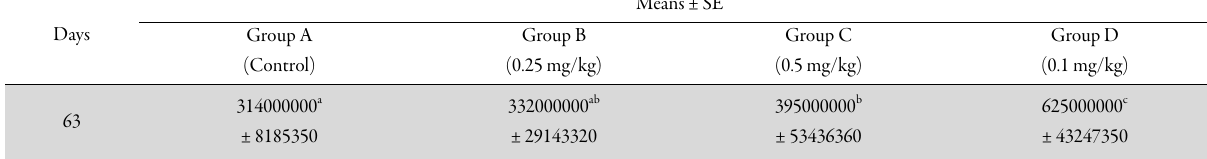
Table 6. Mean cauda epididymal sperm reserves of albino rats given graded doses of whole quail egg per kilogram body weight (± SEM)